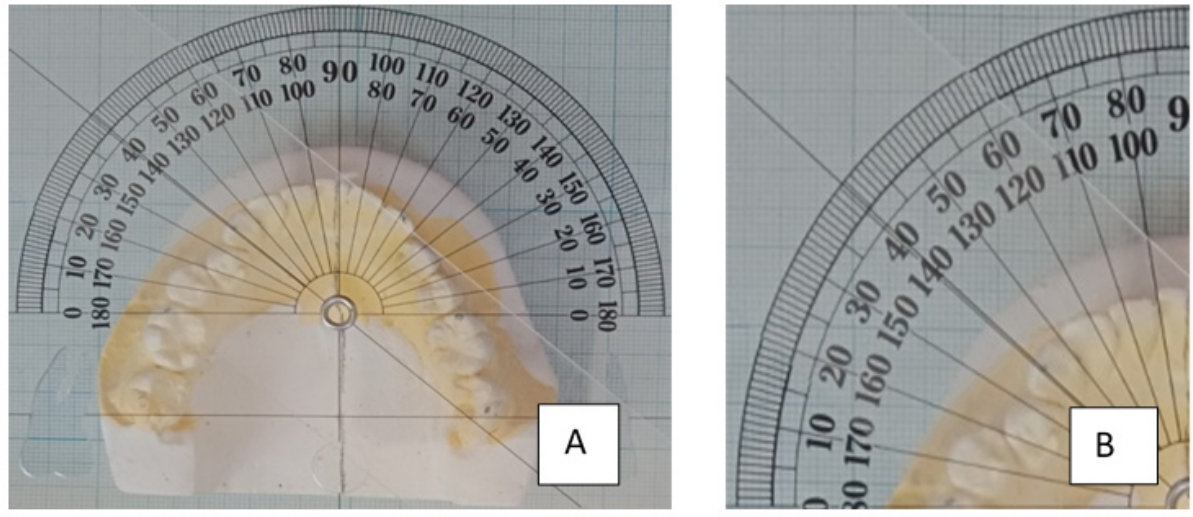
Figure 2. Measuring angular lower arch asymmetry. The plaster cast model is positioned with a protractor at the cusp of the right lower canine ( A ); the protractor shows that PC of right lower arch canine is 39°±1° ( B ).